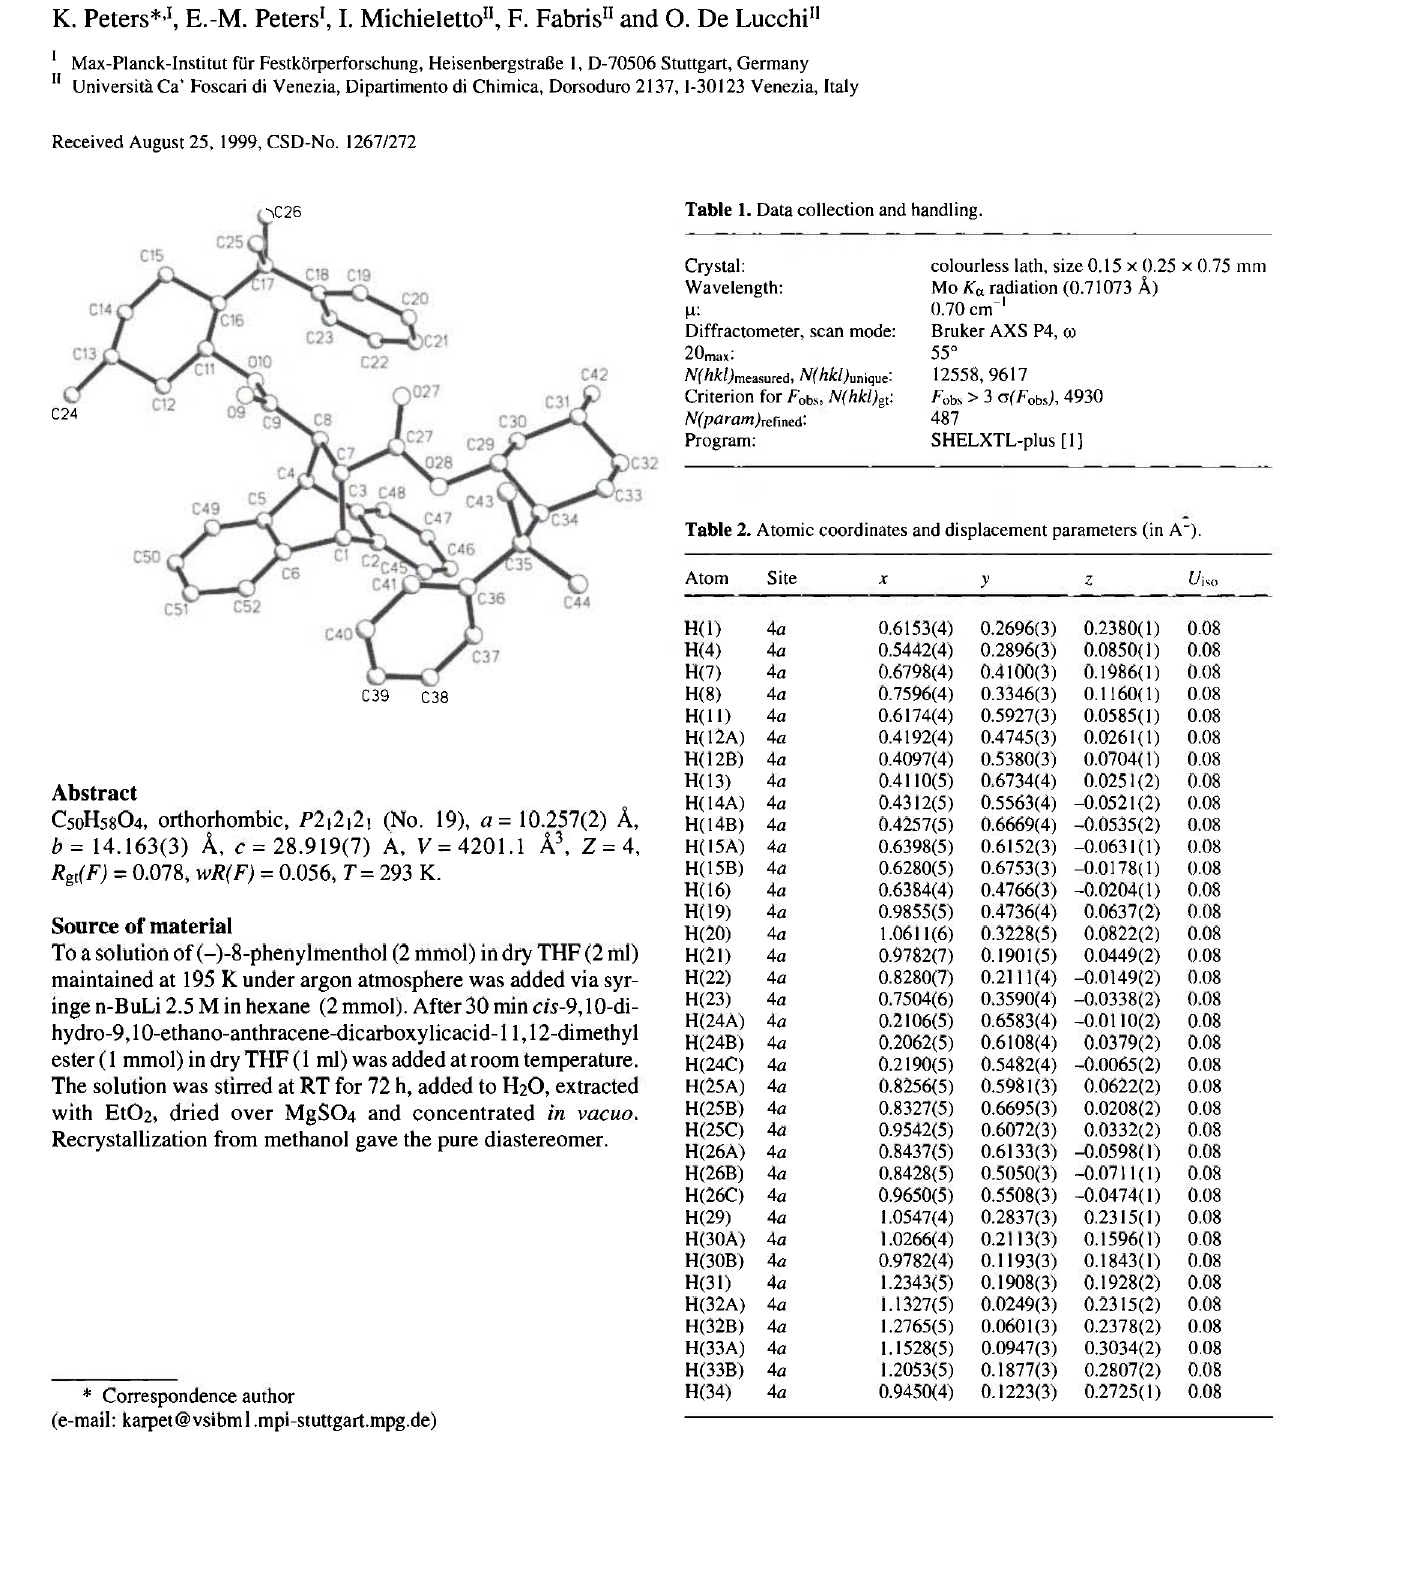
Table 2. Atomic coordinates and displacement parameters (in